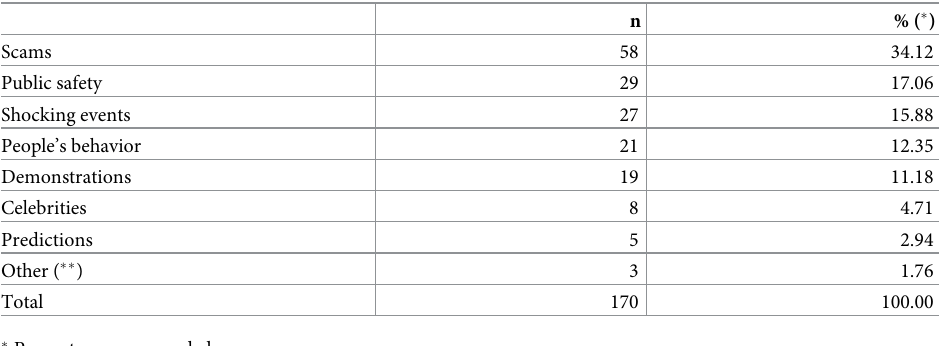
Table 3. Content of hoaxes in the “other” category.